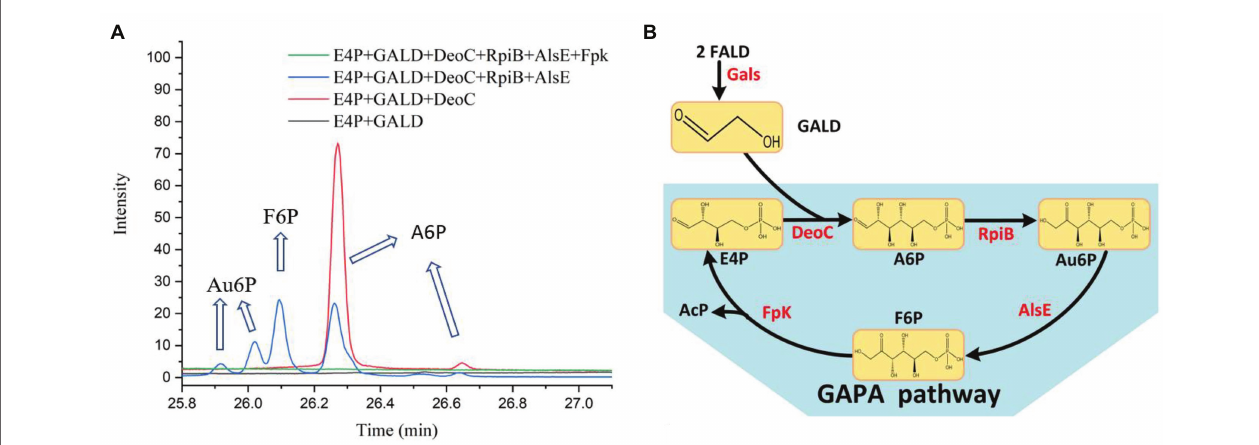
FIGURE 7 | Identification of the GAPA pathway. (A) The reaction products of the condensation of GALD with E4P by DeoC, RpiB, AlsE, and/or Fpk as determined by GC-TOFMS. (B) The proved GAPA